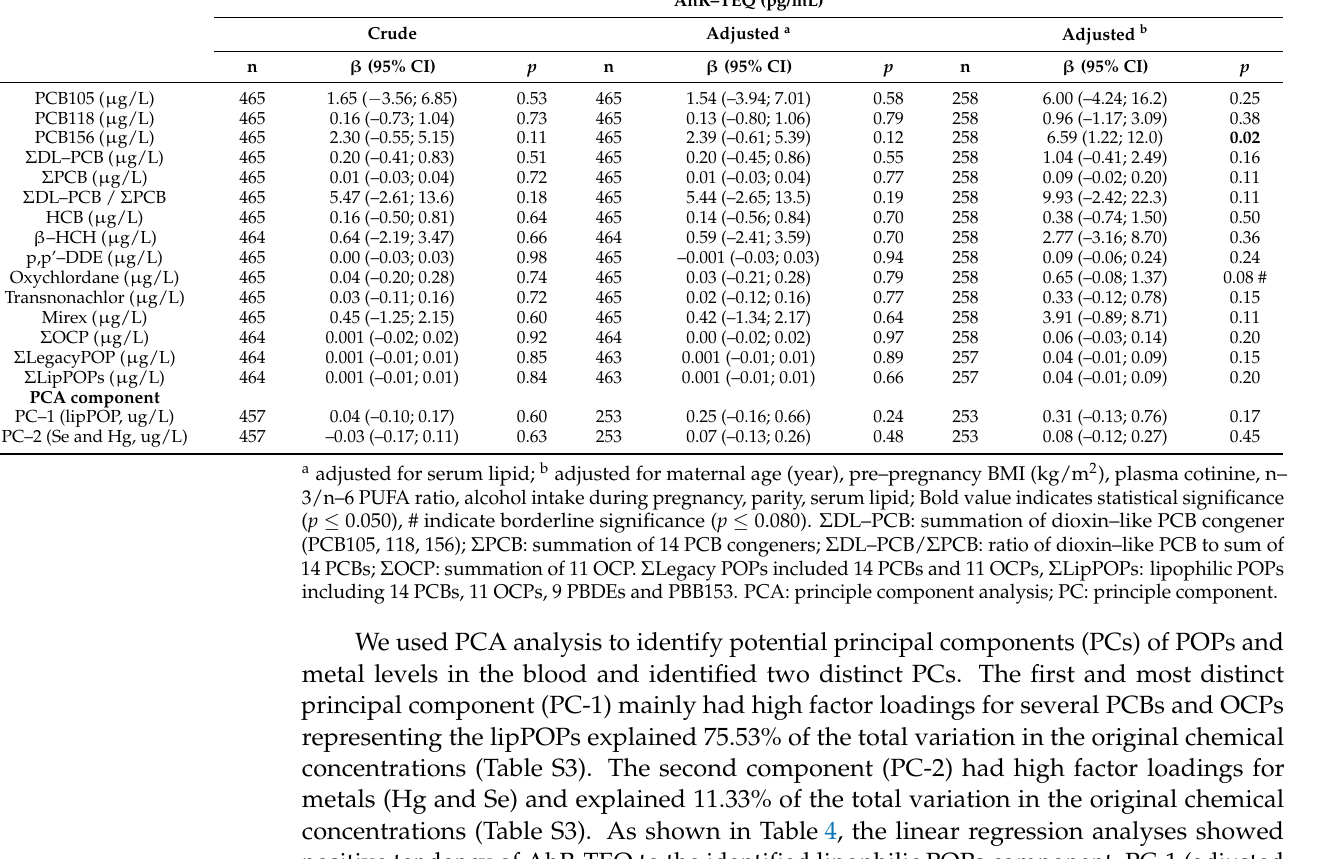
Table 4. The association of serum lipPOPs, principle component and AhR–TEQ. AhR–TEQ